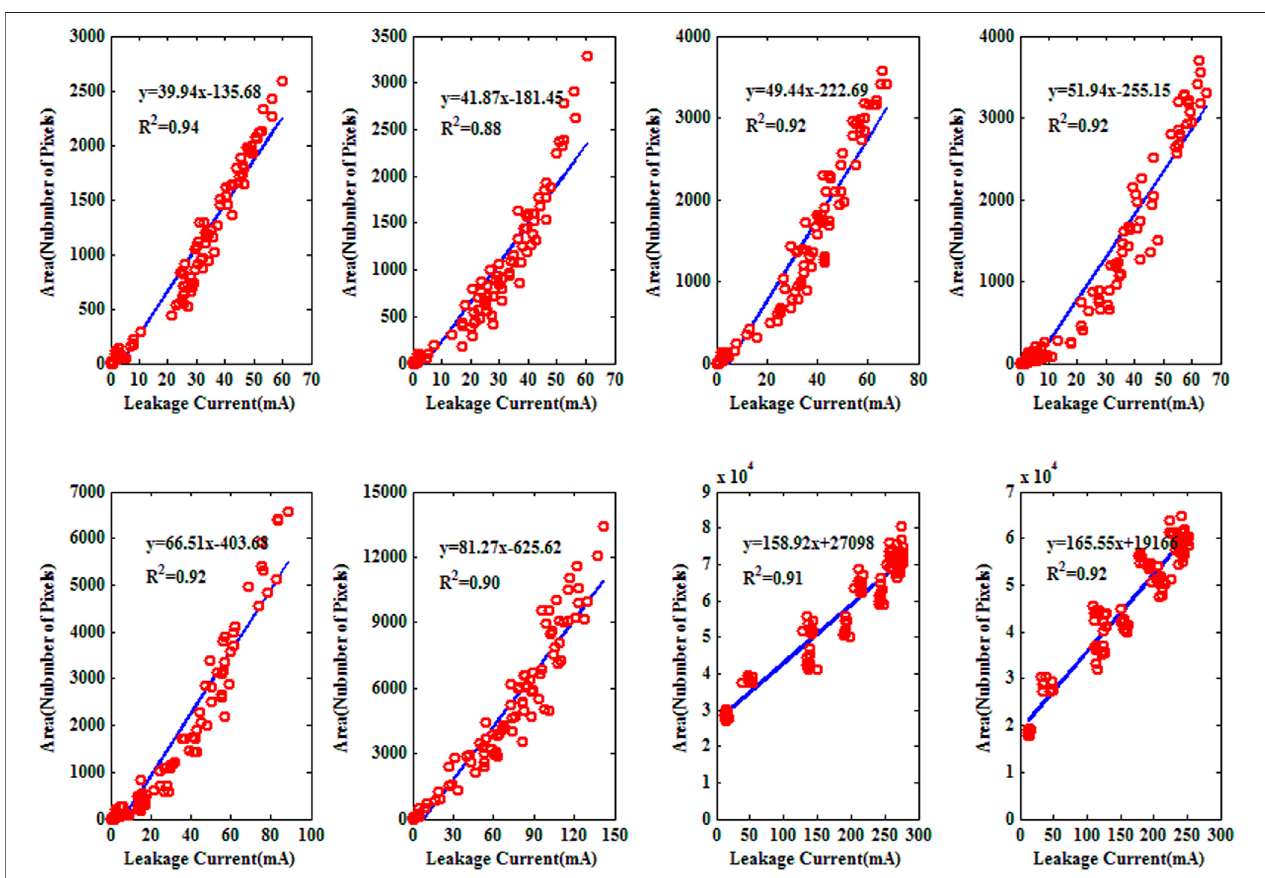
FIGURE 6 | Relation between leakage current and the arc